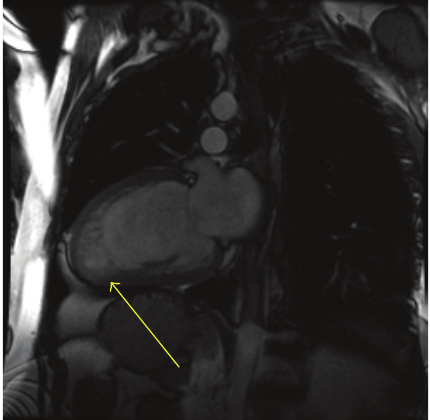
Figure 1: Cardiac magnetic resonance imaging (CMR) of a 38-year- old male that presented with a new cardiomyopathy and congestive heart failure. Note the prominent apical trabeculations compared to the compacted myocardium. Cardiac catheterization demonstrated no angiographic coronary disease and LVNC was the most likely